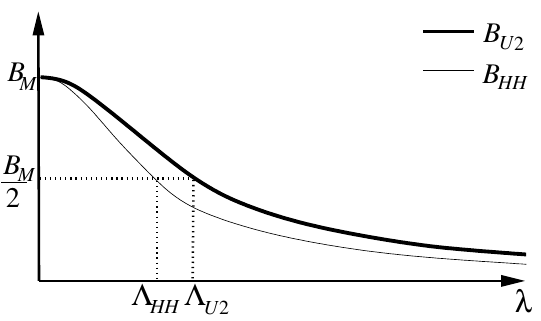
Figure 14. Suppression of the Unruh vacuum decay as a function of BH temperature T BH = λ/ (2 π ) (thick line). The critical temperature Λ (eq. (5.36)) marks the transition from the low-temperature U 2 regime dominated by bounce solutions in the near-horizon region to high-temperature stochastic jumps over the potential barrier. The suppression of the Hartle-Hawking vacuum decay is shown by the thin line for comparison, with the critical temperature Λ given by eq. (5.6). B is the value HH M of the suppression in the absence of BH, eq.